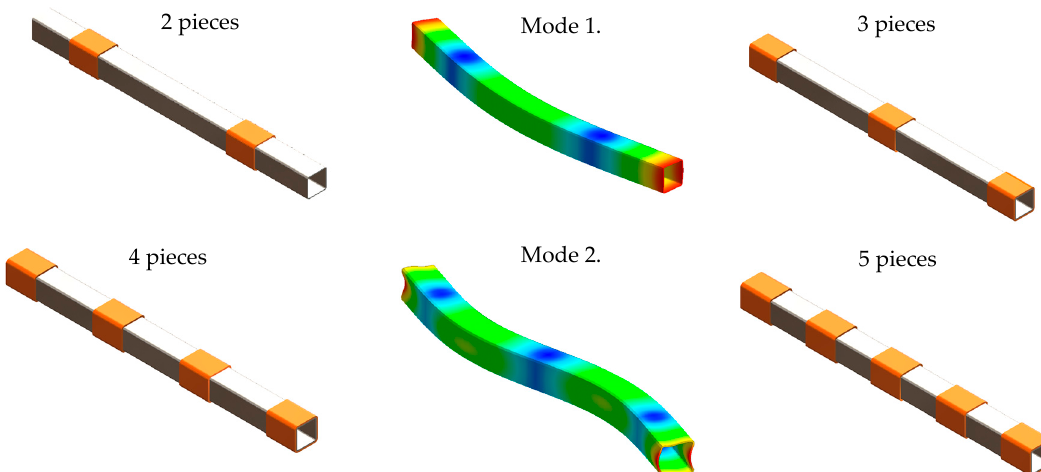
Figure 7. Mode shapes of steel beam and variants with di ff erent locations of the PLA covers subjected to further analysis.